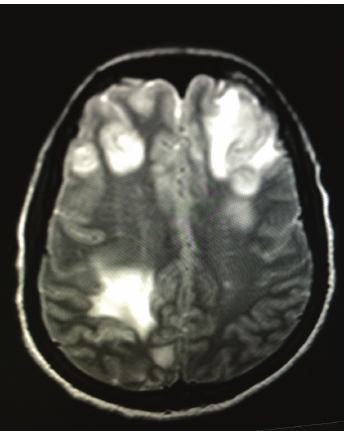
Figure 1: MRI-T2-Axial View: vasogenic edema of basal ganglia. Figure 2: MRI-T2-Axial View: left frontal and right parietal.